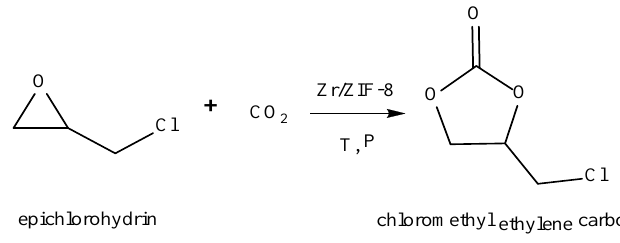
Figure 3. Schematic representation of ECH–CO 2 cycloaddition reaction.